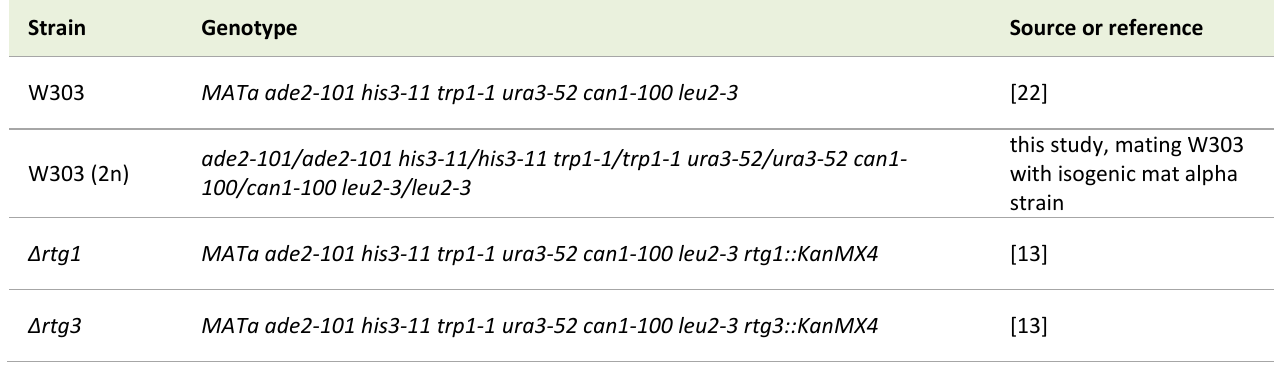
TABLE 2. Yeast strains used in this